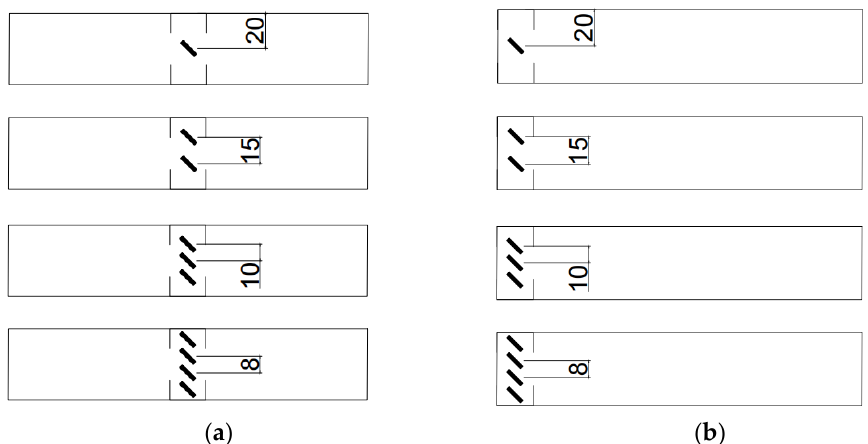
Figure 2. Arrangement of staples for withdrawal and lateral holding strength test specimens: ( a ) withdrawal and ( b ) lateral holding.